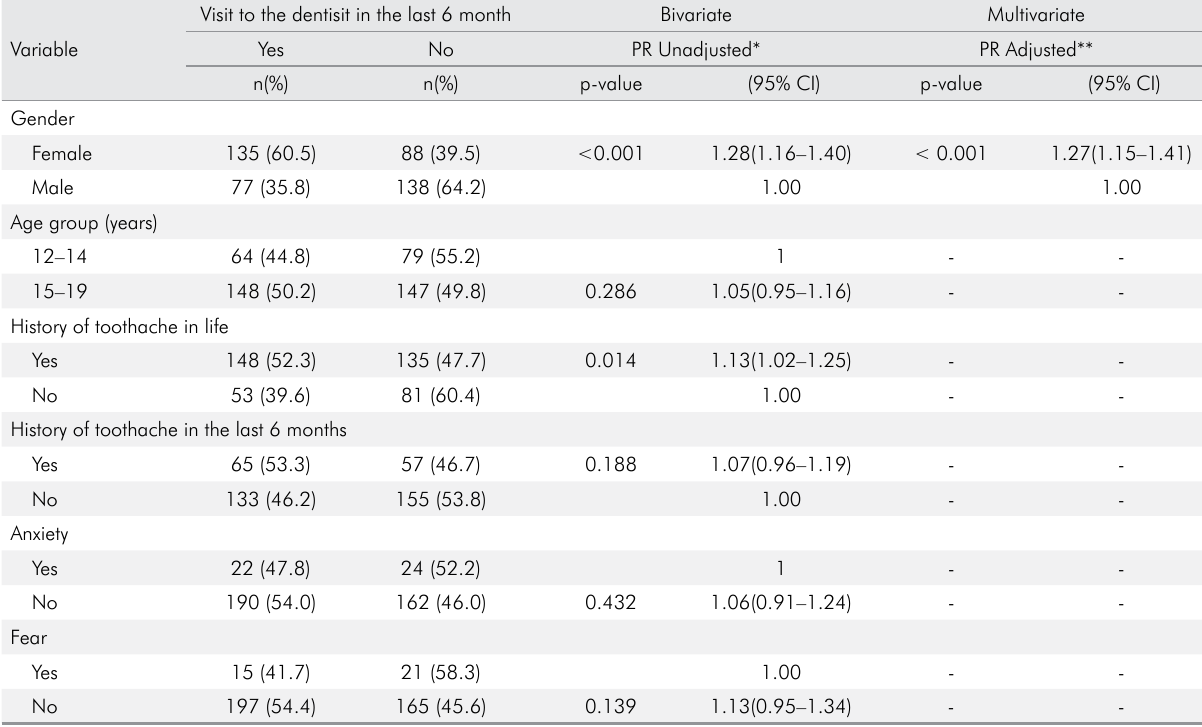
Table 2. Bivariate and multivariate analysis through the Poisson regression in relation to the visit to the dentist in the last 6 months and its associated factors among adolescents of public schools. Campina Grande,